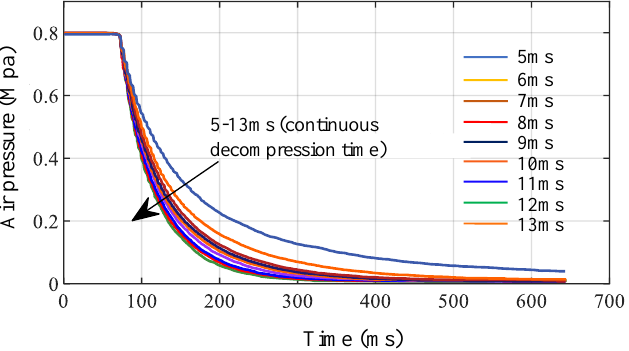
Figure 11. Relationship curve between the depressurization rate and depressurization duration.